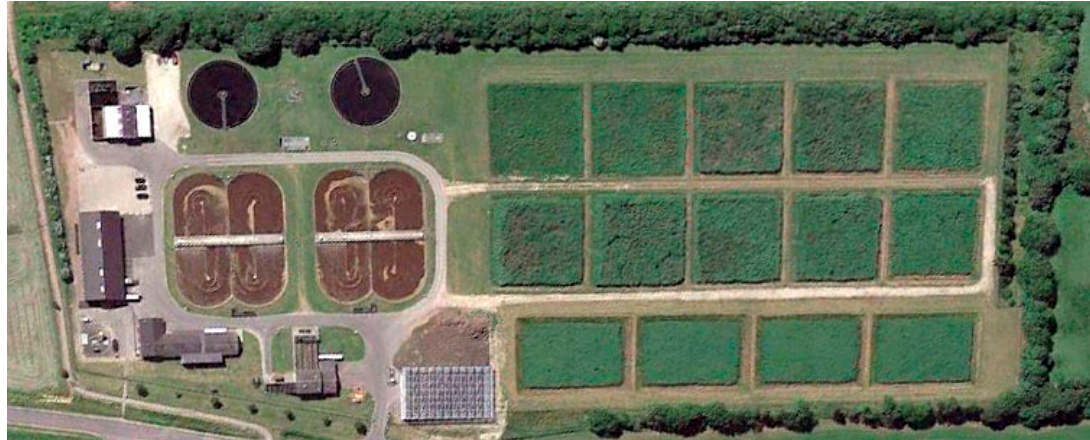
Figure 3. Overview of a typical 40,000 person equivalent sludge treatment reed bed system in Helsinge, Denmark (56°00 ′ 41 ″ N; 12°11 ′ 29.4 E, February 2015). The surplus sludge from the activated sludge treatment systems to the left is pumped to fourteen reed beds in sequence. The water draining from the reed beds (reject water) is returned to the activated sludge tanks. When the beds are filled up with sludge after 8 to 12 years, the dewatered and partly mineralized sludge are used as a fertilizer in agriculture. The Helsinge system was established in 1996 with ten beds. The system was expanded with four extra beds in 2013.